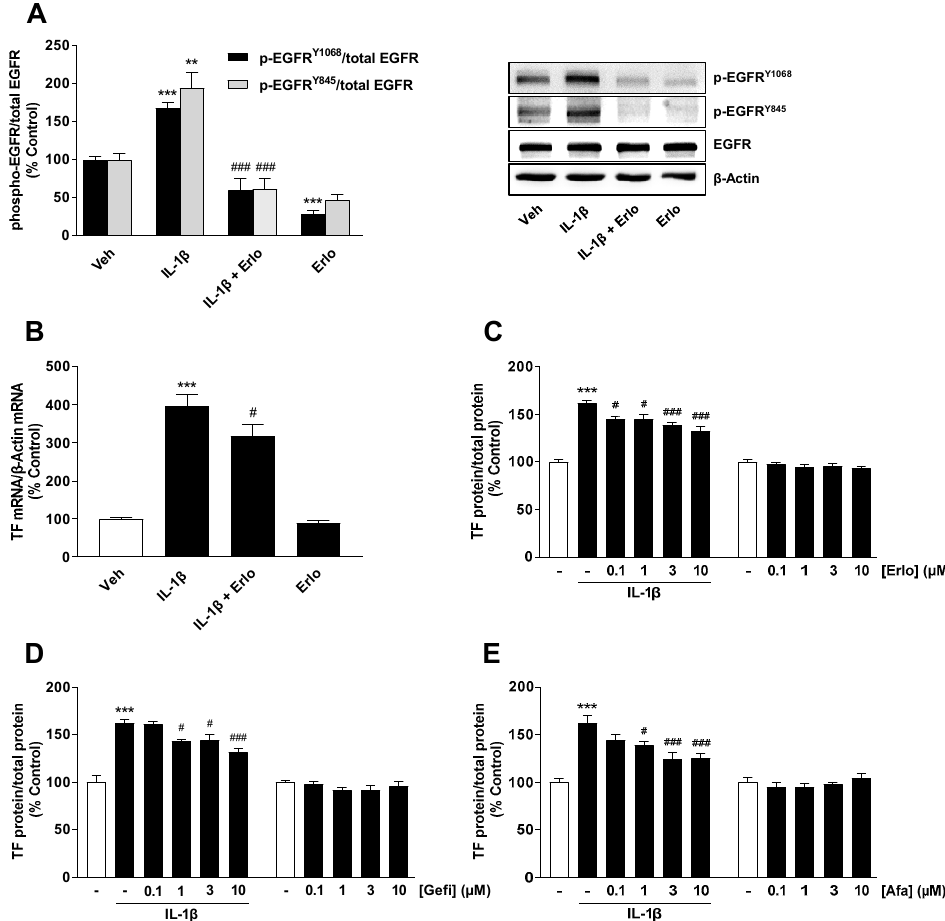
Figure 4. Therapeutically used EGFR TKIs suppress TF expression in A549 cells. ( A ) Effect of erlotinib (Erlo) at 3 µM on IL-1 β -induced or basal EGFR activation at Tyr1068 and Tyr845. Effect of erlotinib on IL-1 β -induced or basal TF mRNA ( B , at 3 µM) and protein ( C , at the concentrations indicated). ( D , E ) Effect of gefitinib (Gefi) and afatinib (Afa) on IL-1 β -induced or basal TF protein at the concentrations indicated. The cells were incubated in the presence or absence of IL-1 β (10 ng/mL) for 10 min ( A ), 2 h ( B ) or 6 h ( C – E ). EGFR TKIs were added to the cells immediately before IL-1 β . All percentage values shown refer to the respective vehicle control, which was set to 100%. The values shown in the first histogram ( A ) are based on densitometric analyses of blots, whereby the phosphorylated forms were normalized to the respective total form. In the labelling of the EGFR blots ( A ) and in the legend of the histogram ( A ), the prefix “p-” stands for “phospho-”. The blots shown are representative. All data are mean values ± SEM of n = 4 ( A , D , E ), n = 11–12 ( B ) or n = 8 ( C ) experiments per group. ** p ≤ 0.01, *** p ≤ 0.001 vs. corresponding vehicle control; # p ≤ 0.05, ### p ≤ 0.001 vs. IL-1 β ; one-way ANOVA with Bonferroni’s post hoc test. A statistically significant influence of EGFR TKIs on basal TF expression ( C – E , respective columns shown on the right) was excluded by one-way ANOVA with Dunnett’s post hoc test.